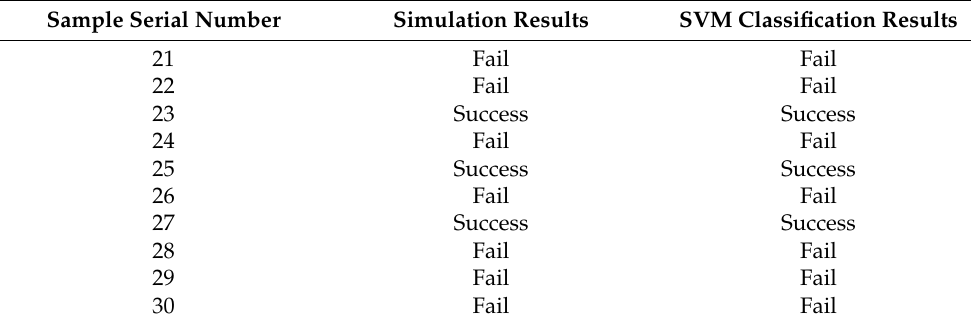
Figure 17. SVM classification results. Table 8. Comparison of test classification results and SVM classification